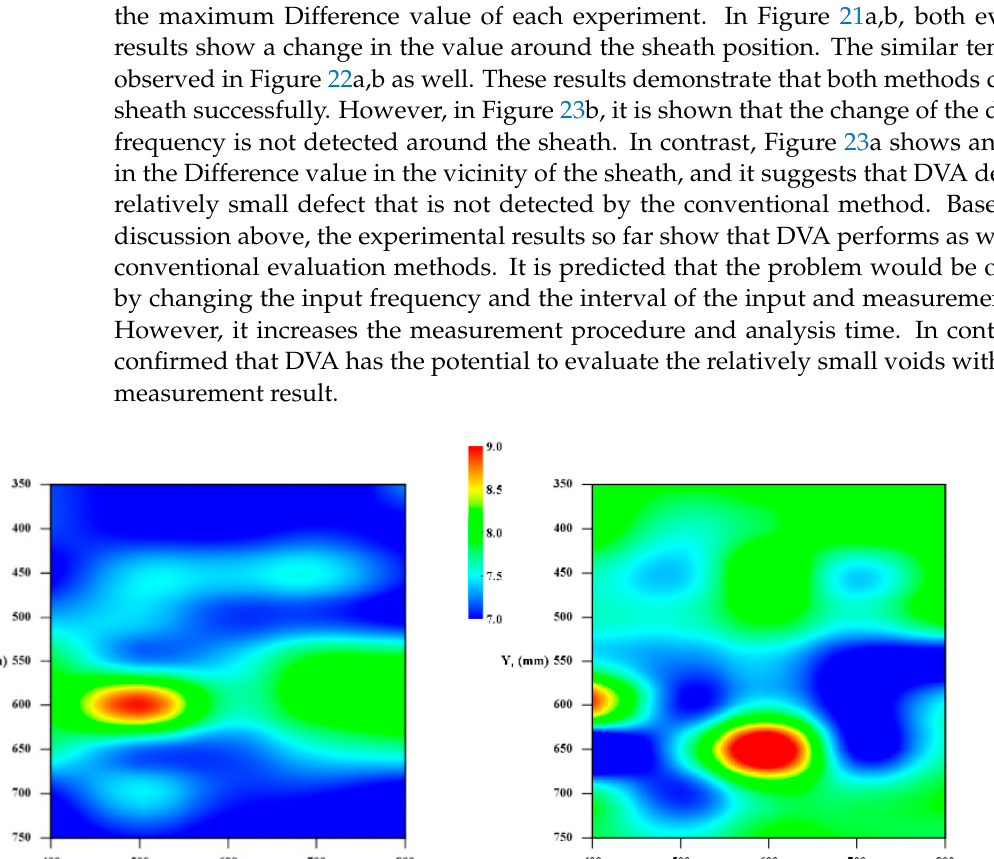
ϕ S = 33 mm, depth = 50 mm.